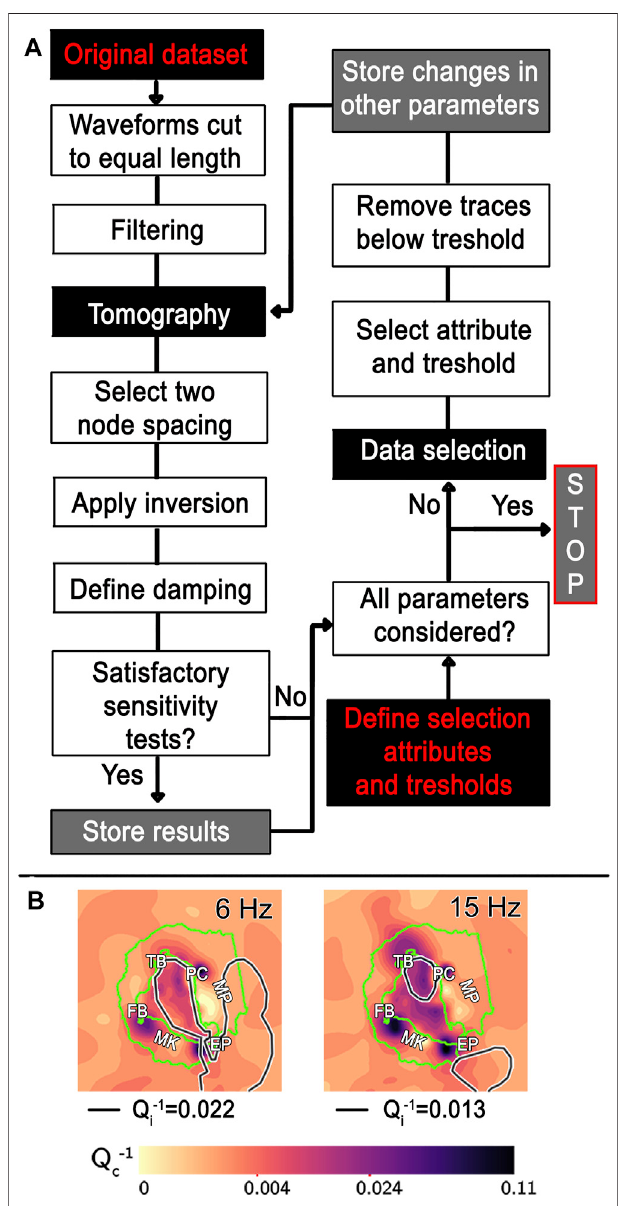
FIGURE 3 | Work fl ow of the selection strategy and fi nal improvement. (A) The work fl ow starts from the available original dataset and a user- dependent choice of selection parameters (black and red boxes). From the original dataset, the work fl ow develops a tomographic analysis whose results are stored after satisfactory recovery of synthetic anomalies. Successiveiterationsdevelopdataselectionsuntilallselectionparametersare considered,andsavethevariationsinallparametersatallsteps.Theiterations stop after all parameters have been evaluated. (B) The results of the fi nal iterations are compared with the contour of the homogeneous absorption ( Q − ) bodies obtained at 6 and 16 Hz by Prudencio et al. (2013). i 1